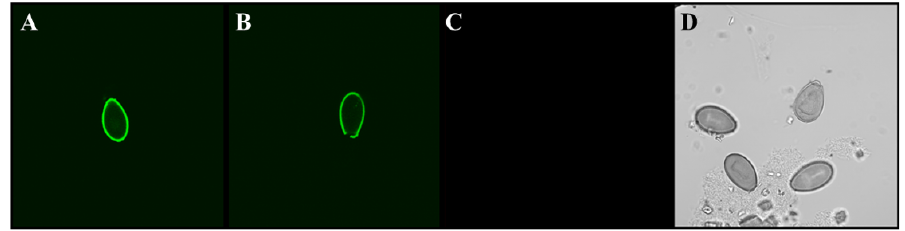
Figure 3. Confocal fluorescence microscopy of C. sinensis eggs stained by the same method described in Figure 2, except that the final 5’-biotinylated aptamer pool was raised against the recombinant C. sinensis egg protein. Panels ( A , B ) show egg surface staining, panel ( C ) represents the appearance of a negative aptamer deletion control and panel ( D ) illustrates the appearance of unstained eggs under phase-contrast microscopy. Total magnification = 400×.